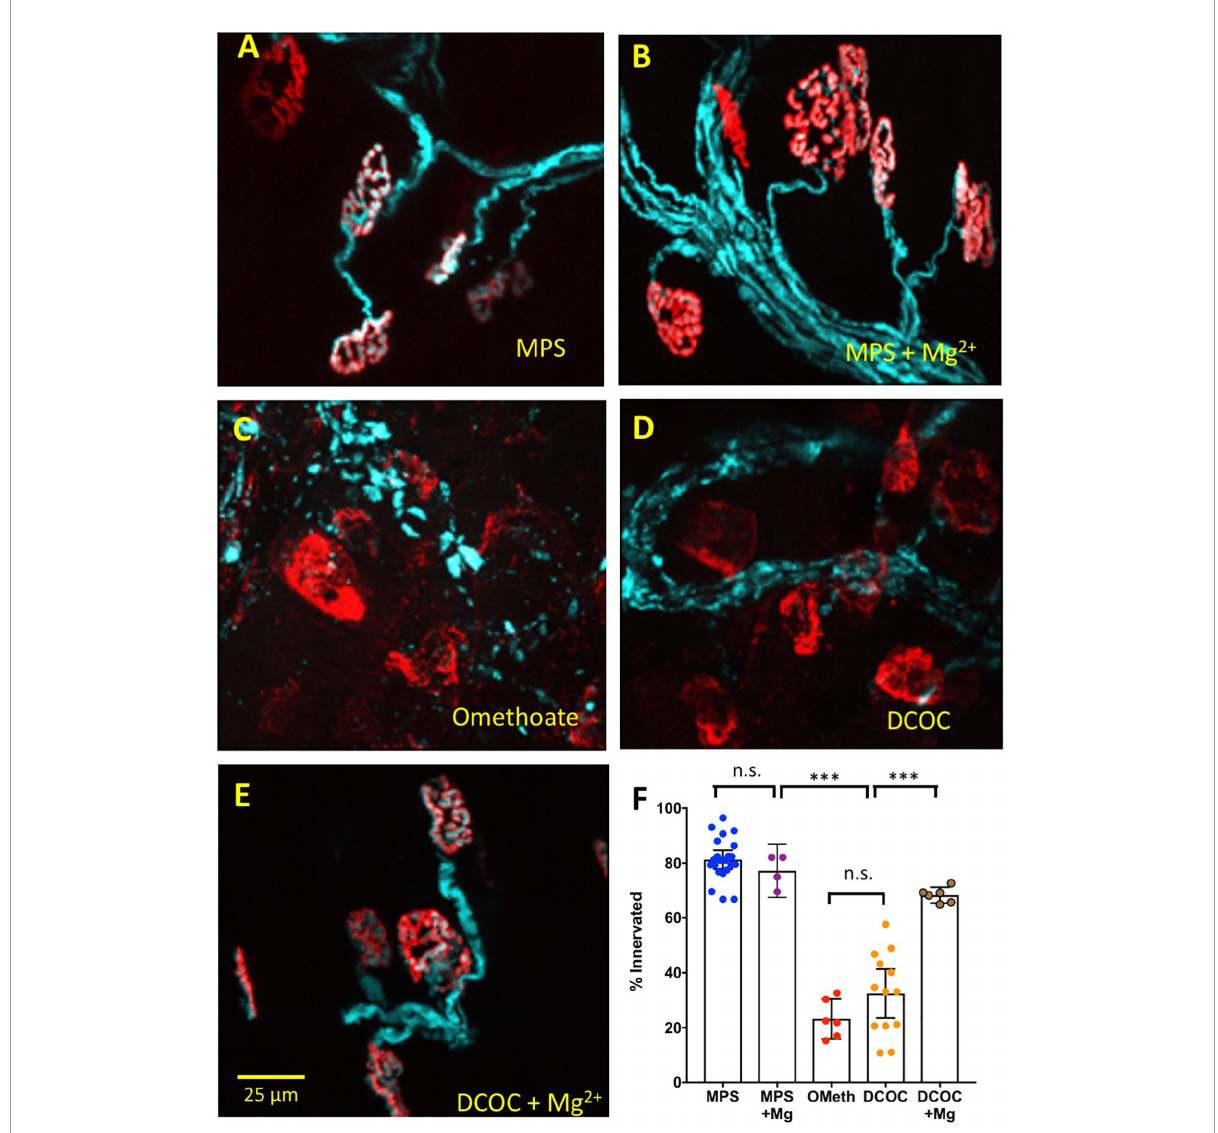
FIGURE7 Mg 2 + also mitigates NMJ degeneration. Data from thy1.2YFP16:Wld S mouse lumbrical muscle preparations maintained for 24 h in oxygenated medium at 32 ◦ C. Pseudocoloured cyan fluorescence is from transgenic co-expression of YFP in motor neurons, including their axons and axon terminals; red counterstain is TRITC- α -BTC labeling of post-synaptic AChR. (A) Almost all NMJs remain innervated after 24 h culture in MPS; (B) 24 h incubation in MPS containing 5 mM Mg 2 + did not change the protective effect of Wld S . (C) Incubation in MPS containing 100 µ M omethoate overrode the Wld S protective phenotype and provoked degeneration and denervation of motor endplates at most NMJs. (D) Extensive degeneration and denervation was also found after 24 h incubation in a cocktail of dimethoate insecticide components dimethoate (1 mM), cyclohexanone (1 mM) and respective metabolites omethoate (100 µ M) and cyclohexanol (5 mM). (E) Co-incubation in the DCOC cocktail with Mg 2 + increased to 5 mM resulted in substantially less synaptic and intramuscular axonal degeneration. (F) Summary data showing percentage innervation of endplates after 24 h incubation in MPS, MPS with Mg 2 + increased to 5 mM, 100 µ M omethoate (OMeth), DCOC cocktail, DCOC with Mg 2 + increased to 5 mM. Each point represents the mean percentage innervation from one muscle, based on measurements of 20–30 NMJs per muscle. Asterisks represent results of ANOVA ( ∗∗∗ P < 0.001; n.s.– P > 0.05) and post hoc Sidak’s test based on numbers (n) of muscles ( N = 4–12 mice in each column).